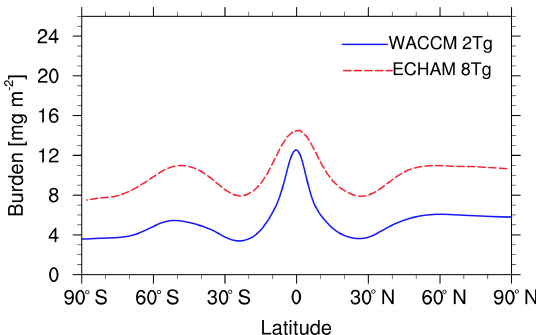
Figure 10. Zonally averaged sulfate burden of a 2Tg ( S ) yr − 1 in- jection rate in WACCM (blue) and an 8Tg ( S ) yr − 1 injection rate in ECHAM-HAM (red, dashed).